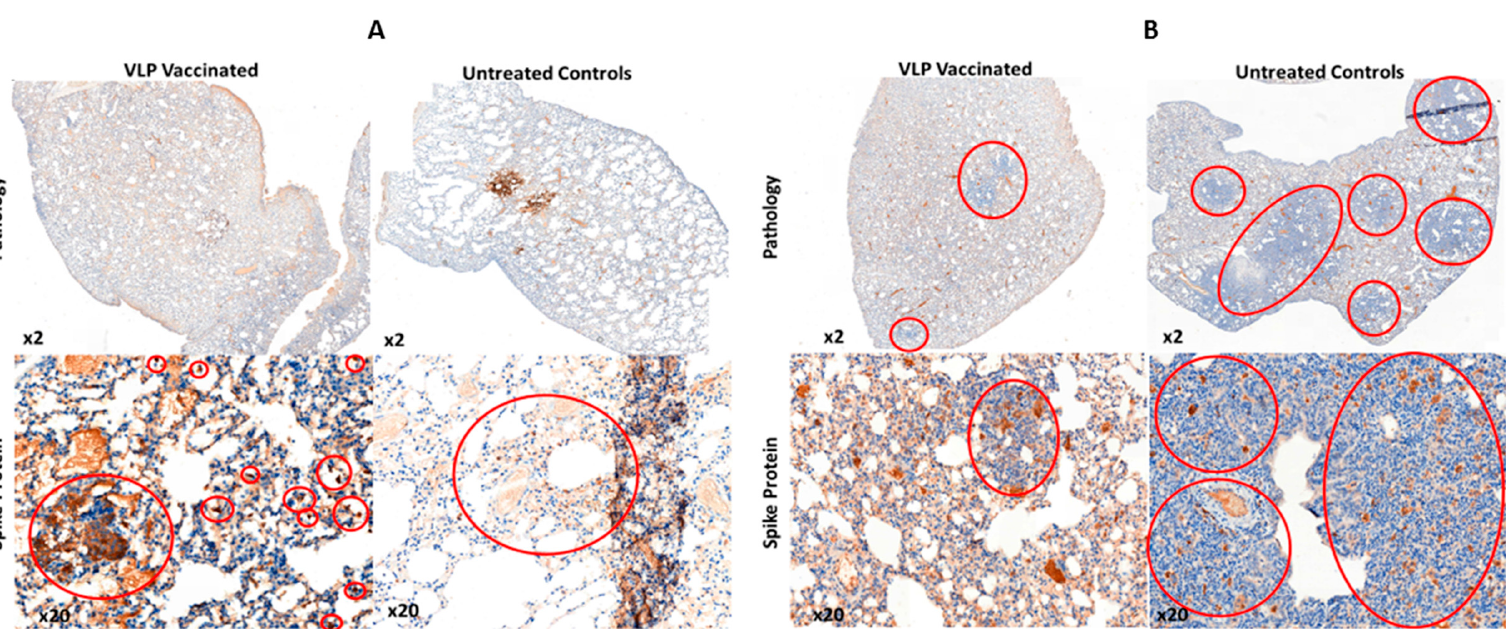
Figure 10. Histology of lung tissue taken from culled animal at 2 days ( A ) and 10 days ( B ) post live virus challenge. Upper panels—gross pathology revealed by H + E staining showing levels of lung sections showing vacuolization and eosinophilia (blue). Lower panels—immunohistochemistry with an anti-S antibody